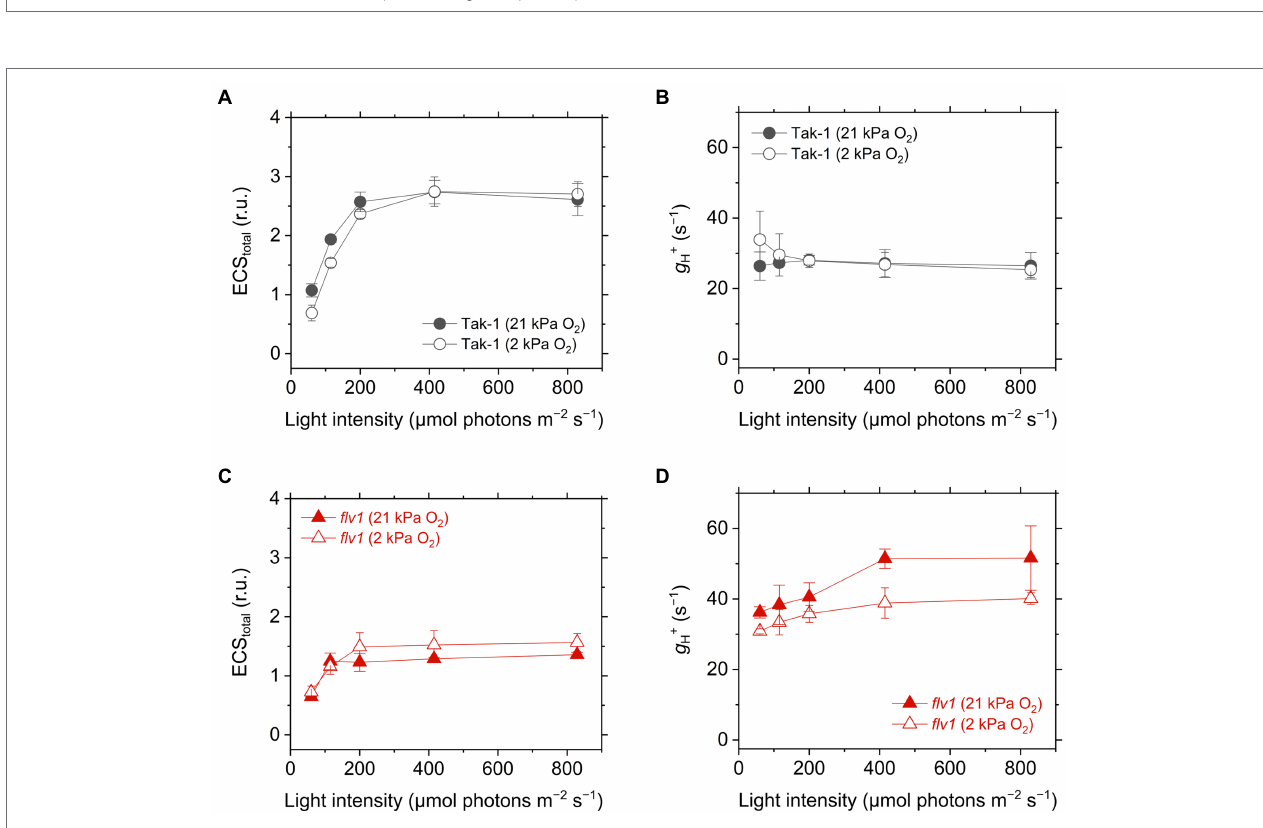
FIGURE 6 | Electrochromic shift (ECS) signal amplitude showing thylakoid membrane potential, termed as ECS total (A,C) , and proton conductance of the chloroplast ATP synthase, termed as g H+ (B,D) , in the liverwort M. polymorpha (Tak-1; A,B ) and the mutant flv1 (B,D) . The relative ECS values were normalized by the ECS amplitude induced by 5- μ s short-saturation flash. Experiments were performed under 21 (closed symbols) and 2 kPa O 2 (open symbols). Data are shown as the mean with the standard deviation ( n = 3, biological